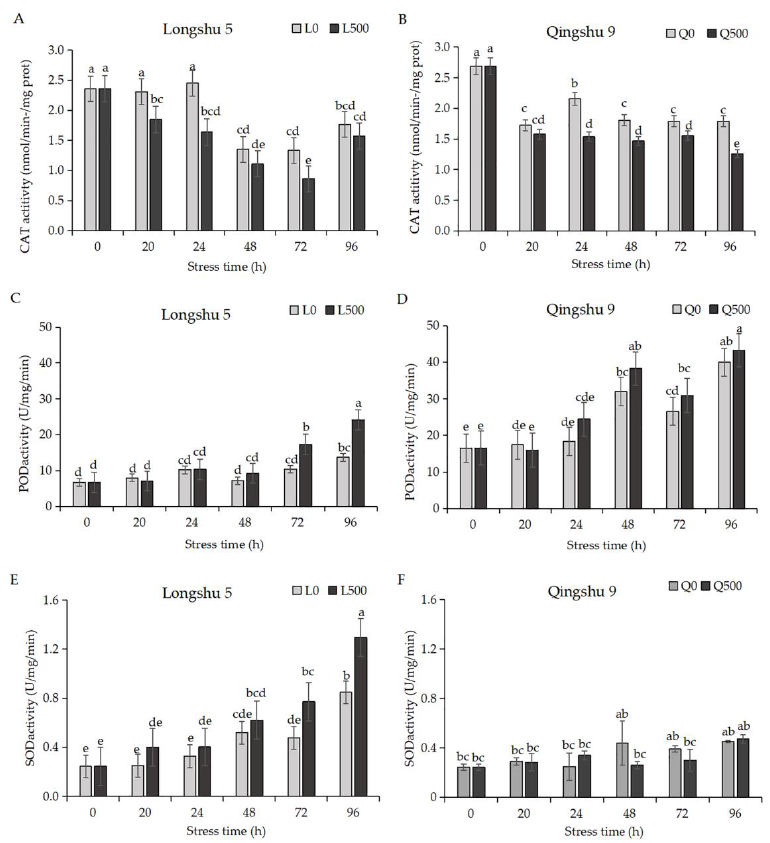
Figure 2. Antioxidant enzyme activity responses to salt stress. “L0” and “L500” represent Longshu 5 exposed to 0 mmol/L and 500 mmol/L NaCl stress, respectively. “Q0” and “Q500” represent Qingshu9 exposure to 0 mmol/L and 500 mmol/L NaCl stress, respectively. ( A ): ‘Longshu 5’ CAT activity, ( B ): ‘Qingshu 9’ CAT activity, ( C ): ‘Longshu 5’ POD activity, ( D ): ‘Qingshu 9’ POD activity, ( E ): ‘Longshu 5’ SOD activity, and ( F ): ‘Qingshu 9’ SOD activity were measured at 0, 20, 24, 48, 72, and 96 h. Gray and black columns show 0 and 500 mmol/L NaCl concentration, respectively. Values are means and bars indicate SDs ( n = 3). Same lowercase letters mean no significant difference, different lowercase letters mean significant difference. CAT, catalase; POD, peroxidase; SOD, superoxide dismutase.